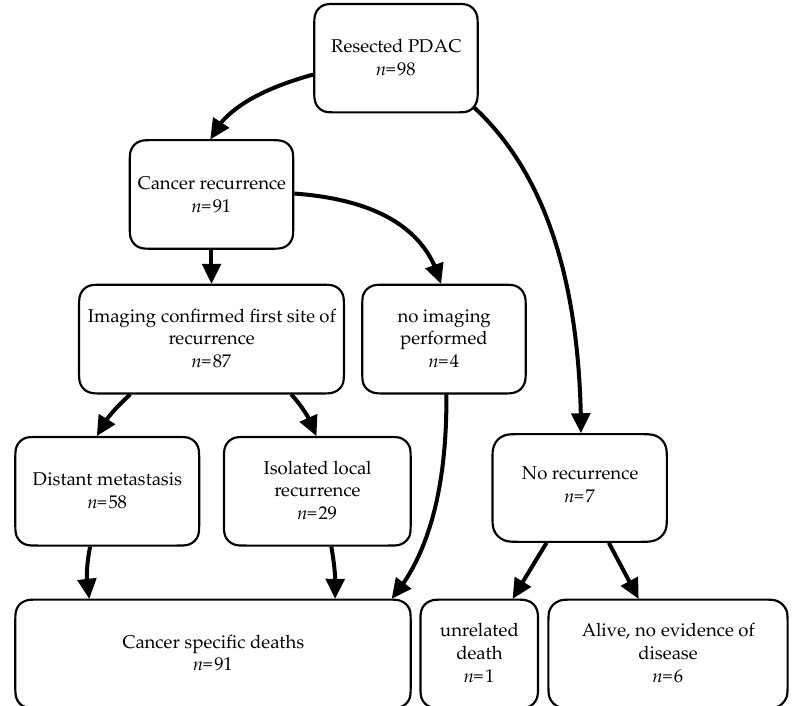
Figure 1. Overview of clinical events for the patient cohort, starting at the time of operation until the outcome stated in the last row at the end-point of observation was reached. PDAC : pancreatic ductal adenocarcinoma.